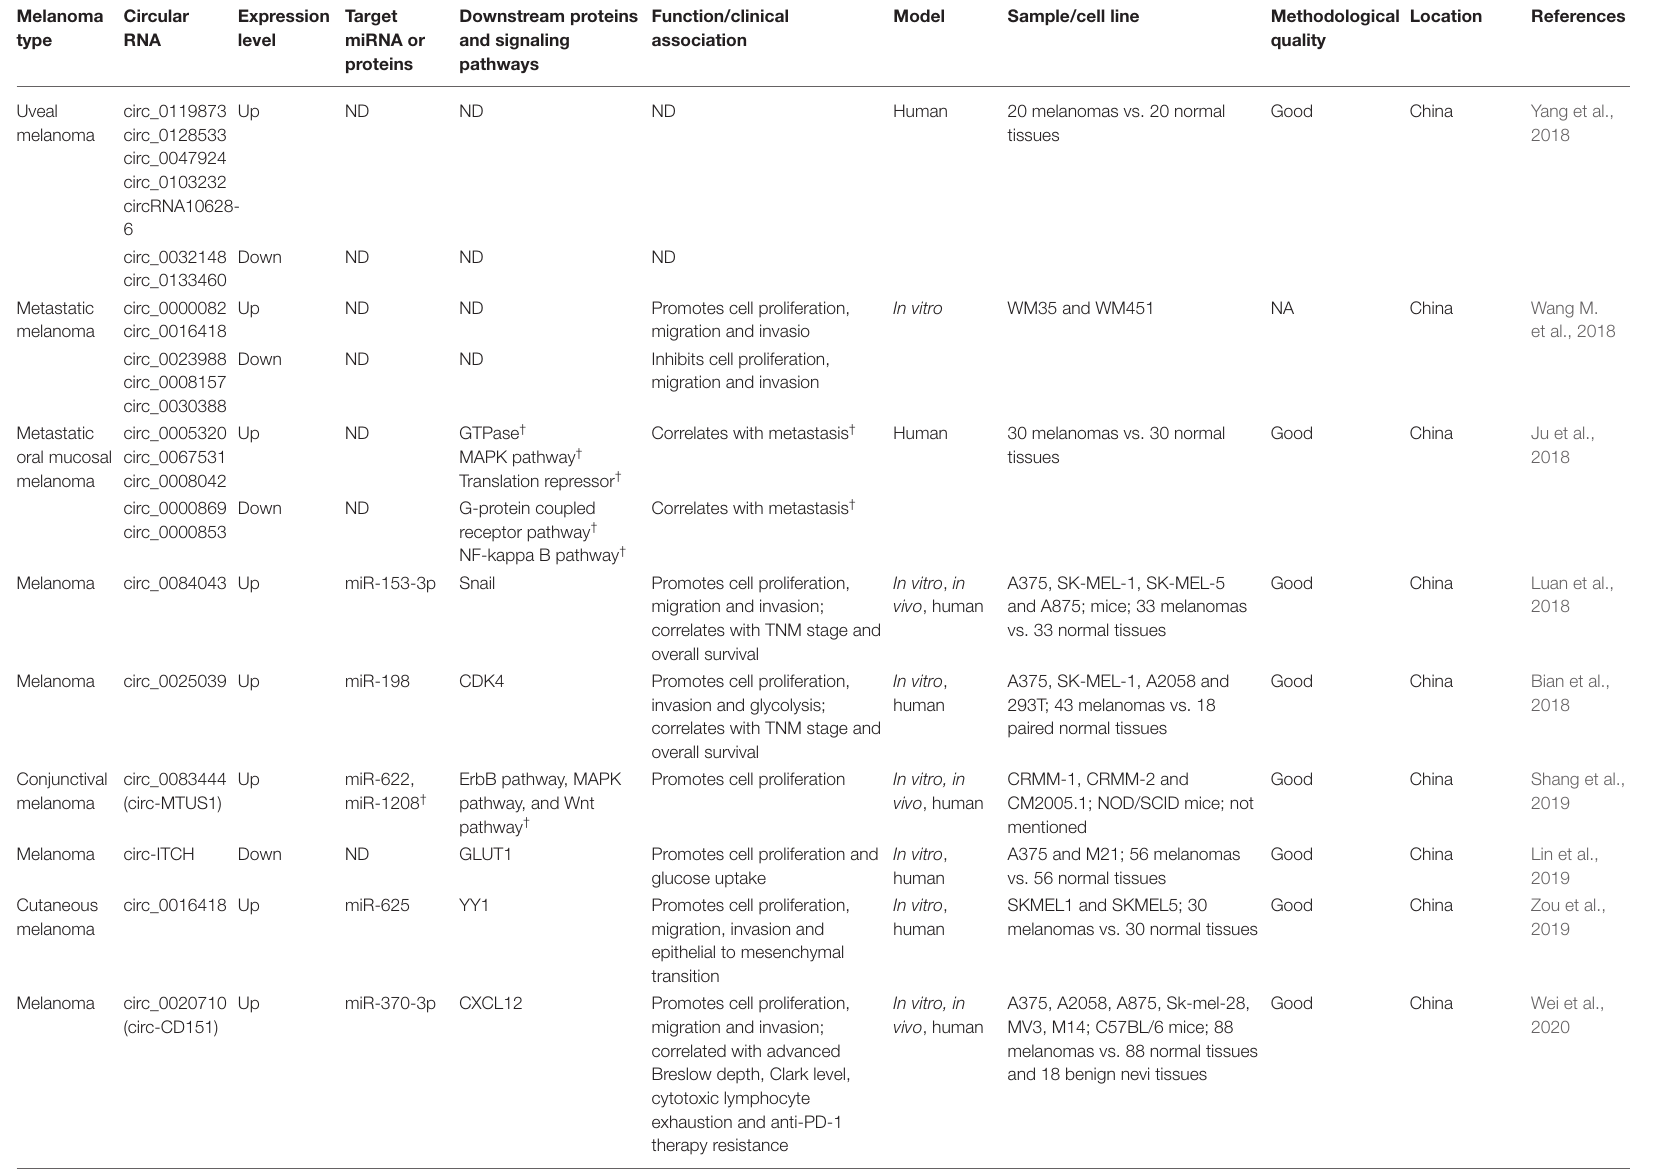
TABLE 1 | Melanoma-associated circRNAs in the included articles. Melanoma